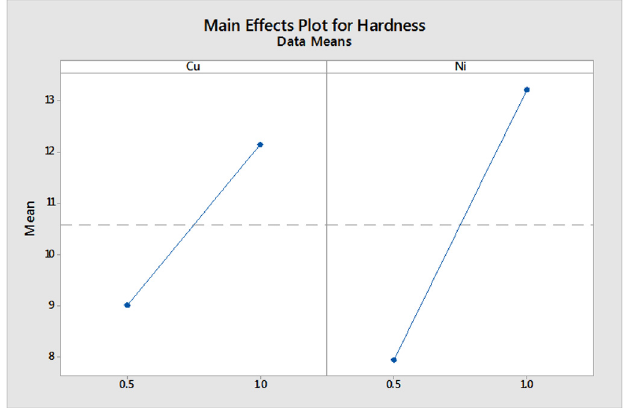
Fig. 2. Mean effects plot for